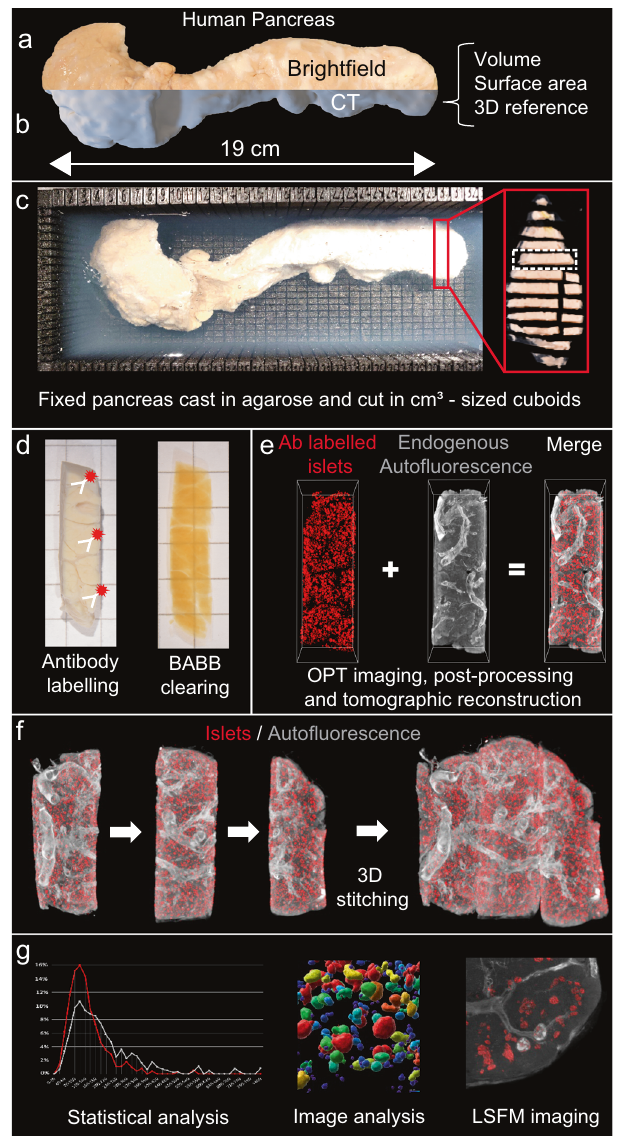
Fig. 1 A pipeline for quantitative molecular 3D imaging of human organs. Schematic outline illustrating the process of tissue processing and image analysis as applied to the human pancreas. By embedding fi xed intact, CT- scanned fi xed pancreas ( a , b ) from diseased donors in agarose, cm3-sized tissue cuboids are sliced and extracted from a 3D printed matrix ( c ). The cuboids are subjected to whole-mount immunohistochemistry and scanned by Near-infrared - OPT 31 ( d , e ). The resultant scan data is post-processed by schemes for image fusion-OPT 37 and CLAHE 32 , and the segmented tomographic data is stitched back into 3D space ( f ) (see also Fig. 2). Hereby, statistical and computational image analyses of the islet mass distribution can be performed including information of the islet ’ s individual 3D coordinates, volumes, and shapes within the context of the entire gland ( g ). In addition, AF features of the tissue may be used to generate contrast for vessels and other structures (see Fig. 3). Since the tissue processing protocols are fully compatible, complementary high-resolution analyses can be performed by LSFM imaging. In all, the produced data provide proof of principle for the applicability of the approach to reconstruct the amount, volume, and distribution of antibody labeled features throughout the volume of the